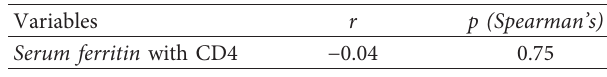
Figure 1: Scatter diagram correlation between serum ferritin with CD4. Table 3: Correlation between serum ferritin with CD4 count in adult TDT patients.